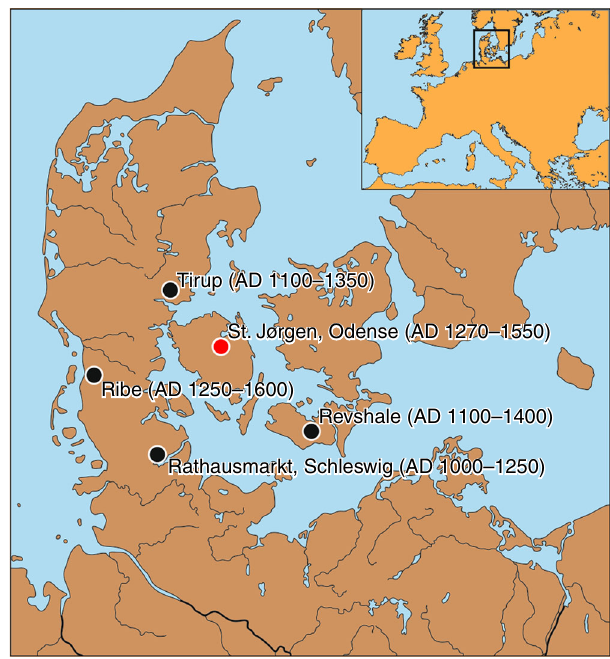
Fig. 1 Origin of medieval samples. Geographic location of the medieval cemeteries in southern Denmark and northern Germany from where the specimens in this study were obtained. Dates in parentheses indicate the time span of active use as cemeteries. Red dot marks the cemetery with LL- positive samples. LL: lepromatous leprosy. The software CorelDRAW was used to create the map (designed by